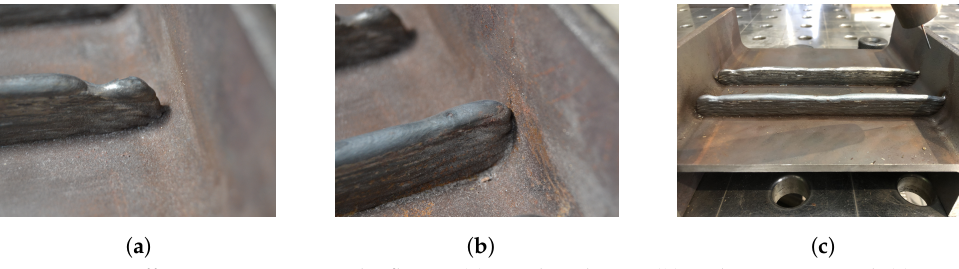
Figure 14. Insufficient connection to the flange: ( a ) too short layers; ( b ) without compound; ( c ) errors concerning clamping (left: free; right: